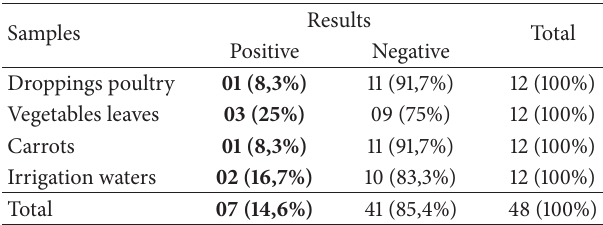
Table 5: Summary of the results of the samples of gardens 1, 2, and 3 using droppings of poultry.